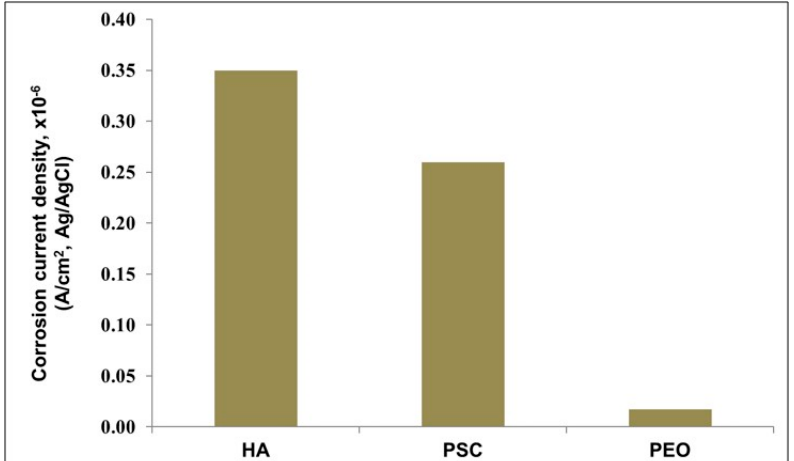
Figure 10. Determination of corrosion current density for ( a ) Al substrate, ( b ) HA, ( c ) PEO and ( d ) PSC coatings.